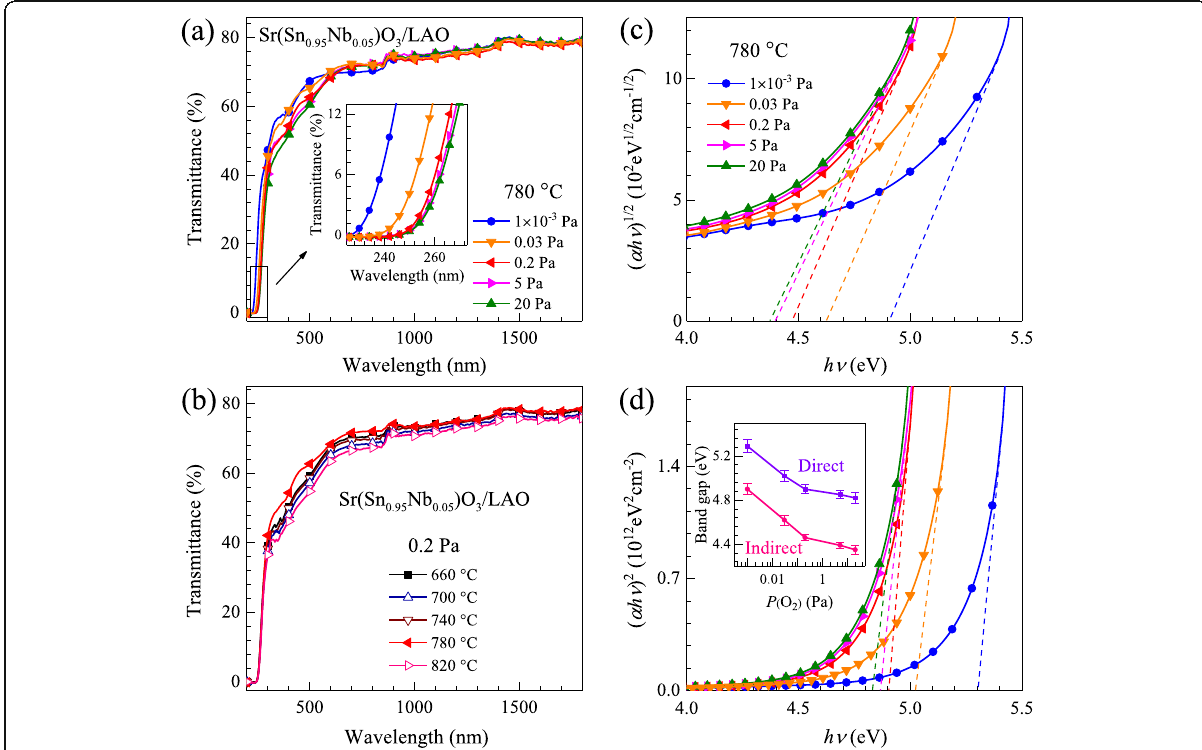
Fig. 6 The optical transmittance of the SSNO films fabricated at ( a ) different oxygen pressures and ( b ) different substrate temperatures in the wavelength range of 200-1800 nm. The plots of ( α h ν ) 1/2 versus h ν and ( α h ν ) 2 versus h ν for the films with various oxygen pressures are shown in Fig. 6c and d, respectively. The inset in Fig. 6d shows the direct and indirect band-gap energy variations by varying oxygen pressure from 1 × 10 − 3 to 20